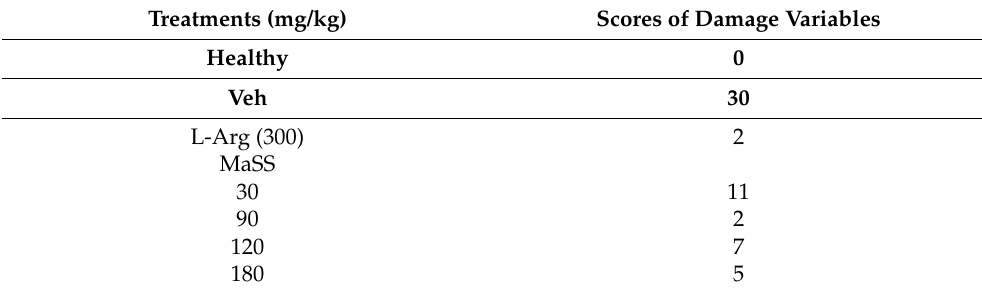
Table 2. Sum of damage scores of variables associated to gastric lesions induced with ethanol. Treatments (mg/kg) Scores of Damage Variables Healthy